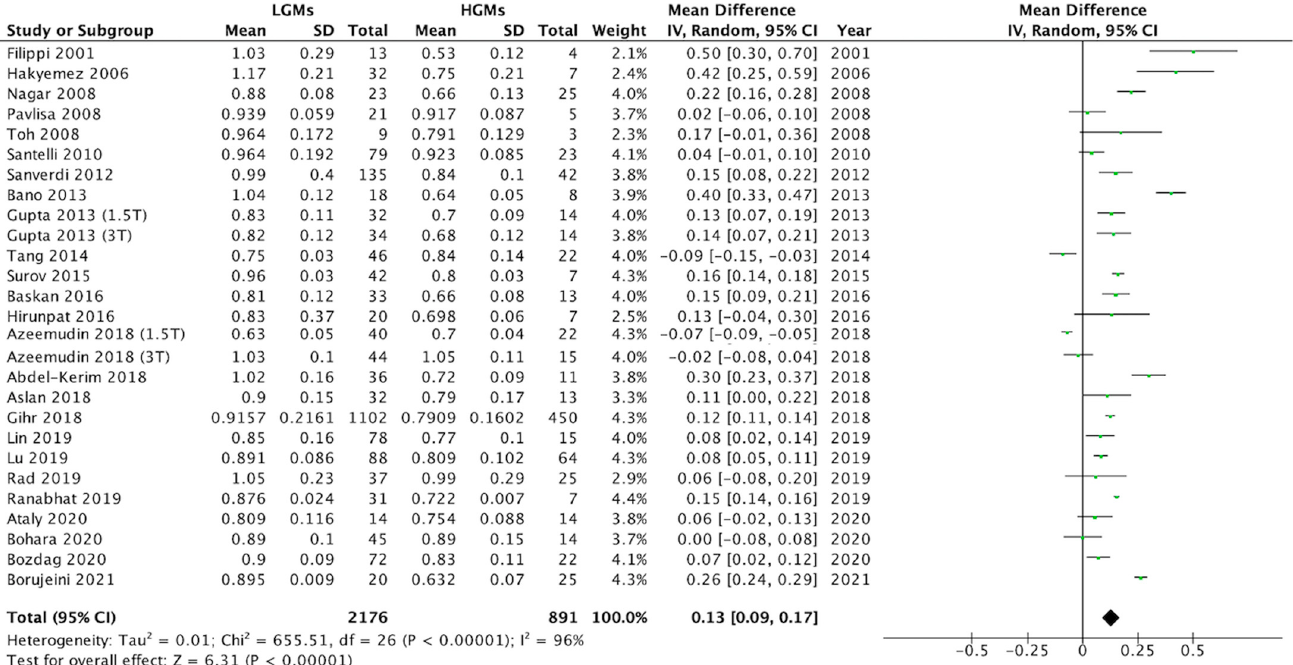
Figure 2. Forest plot for the pooled difference in mean ADC values between LGMs and HGMs. The pooled difference in mean ADC was 0.13 (95% CI = 0.08 to 0.17, p < 0.00001).